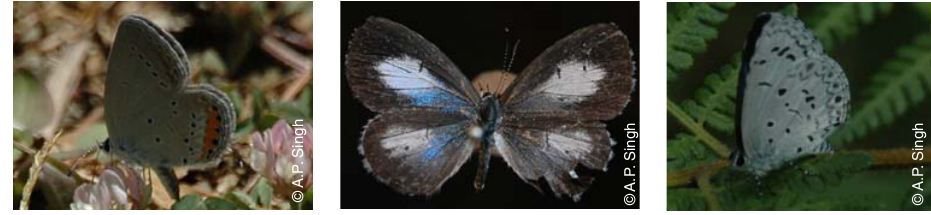
Image 19. Chapmans Cupid, Everes diporides